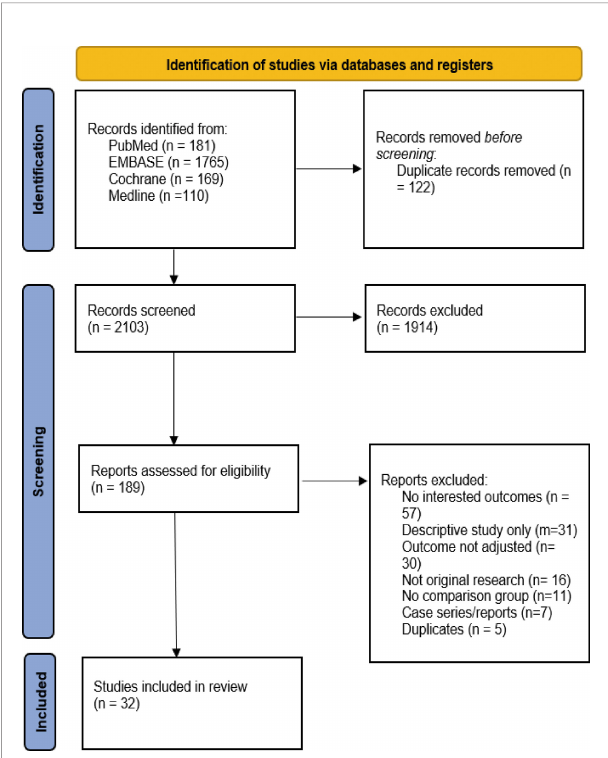
FIGURE 1 | Preferred Reporting Items for Systematic Reviews and Meta- analysis (PRISMA) chart for the literature